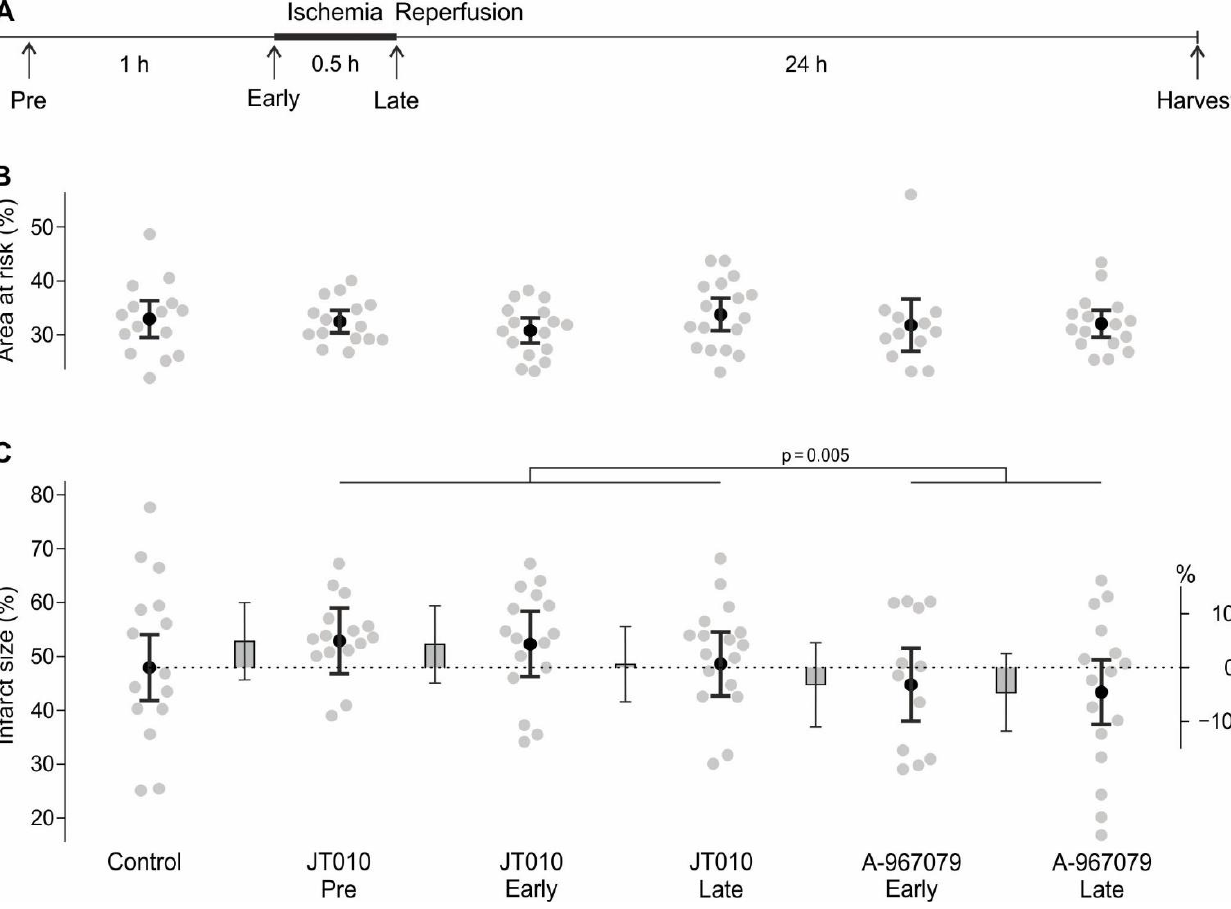
Figure 1. TRPA1 agonists and antagonists had small opposing effects on myocardial infarct size. ( A ) Myocardial IR experimental protocol in rats with time points of treatment indicated by arrows. Rats were treated either 60 min (Pre) or 5 min prior to ischemia (Early) or 5 min prior to reperfusion (Late) with the TRPA1 agonist JT010 (0.4 mg/kg) and Early or Late with the TRPA1 antagonist A-967079 (6.2 mg/kg) i.v. ( B ) Area at risk (% of left ventricle). Each grey symbol represents the result of a single rat, black dots with error bars represent means ± 95% CI. ( C ) Infarct size in percent of left ventricle area at risk 24 h after myocardial IR. As above, grey symbols represent results of single rats and black dots means ± 95% CI. Estimated differences to control are shown as grey bars ± 95% CI and refer to the right y -axis.